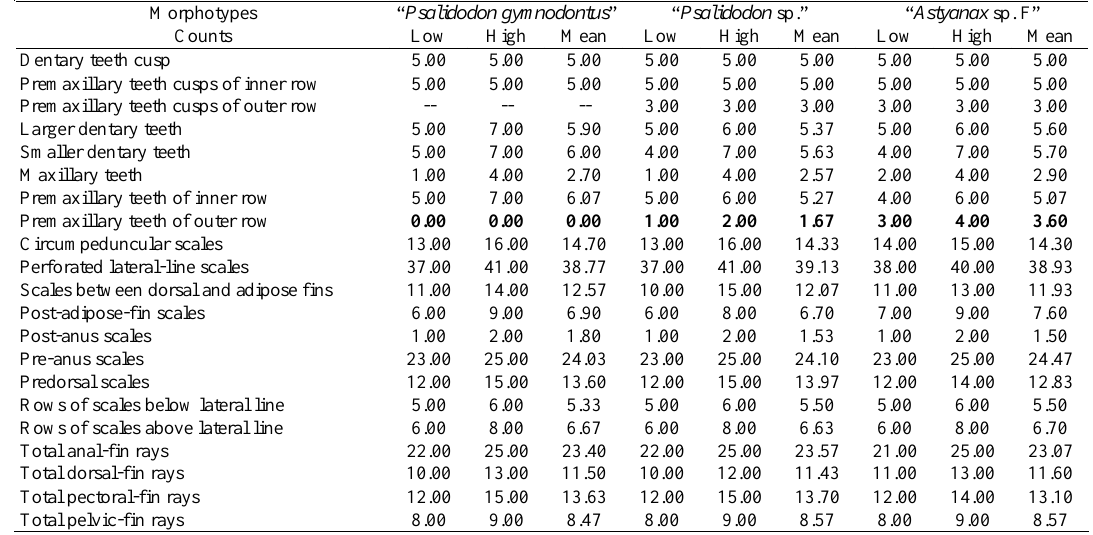
Table 3. Counts from 30 specimens of the 3 morphotypes of Astyanax gymnodontus , with the arbitrary difference in the premaxillary teeth of the outer row shown in